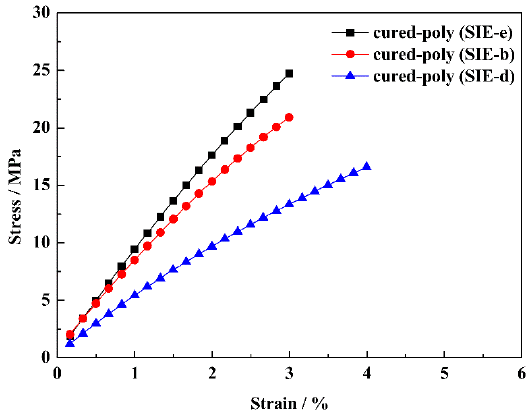
Figure 10. Stress-strain curves of different cured polymers.